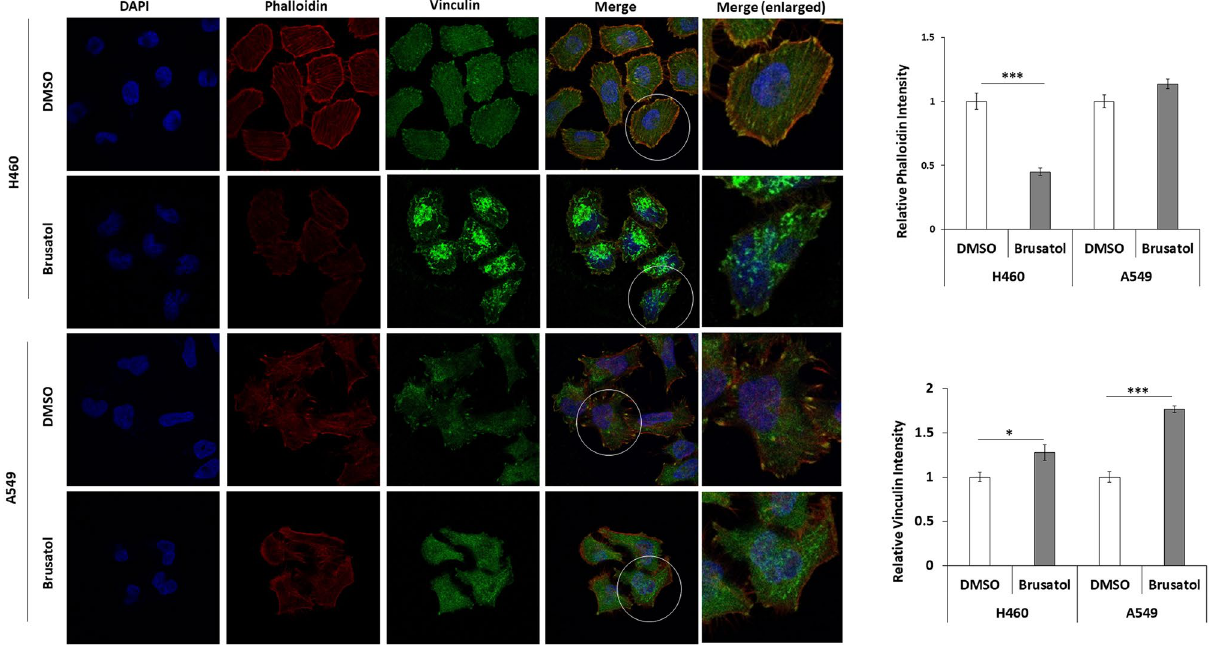
Figure 5. Nrf2 is associated with the formation of F-actin stress fibres with focal adhesion. Representative images of cells stained with vinculin (green) with rhodamine phalloidin (red) after brusatol treatment (30 nM and 10 nM for A549 and H460 cells, respectively). White circled cell enlarged. Nuclei were counterstained with DAPI (blue). Images were obtained with a confocal laser scanning microscope (LSM 780, ZEISS) and visualised using the 100× oil immersion objective (EC Plan-Neofluar 100×/1.3 oil). Intensity of fluorescence from the captured image of cells was quantified using ImageJ software (Ver. 1/52n,